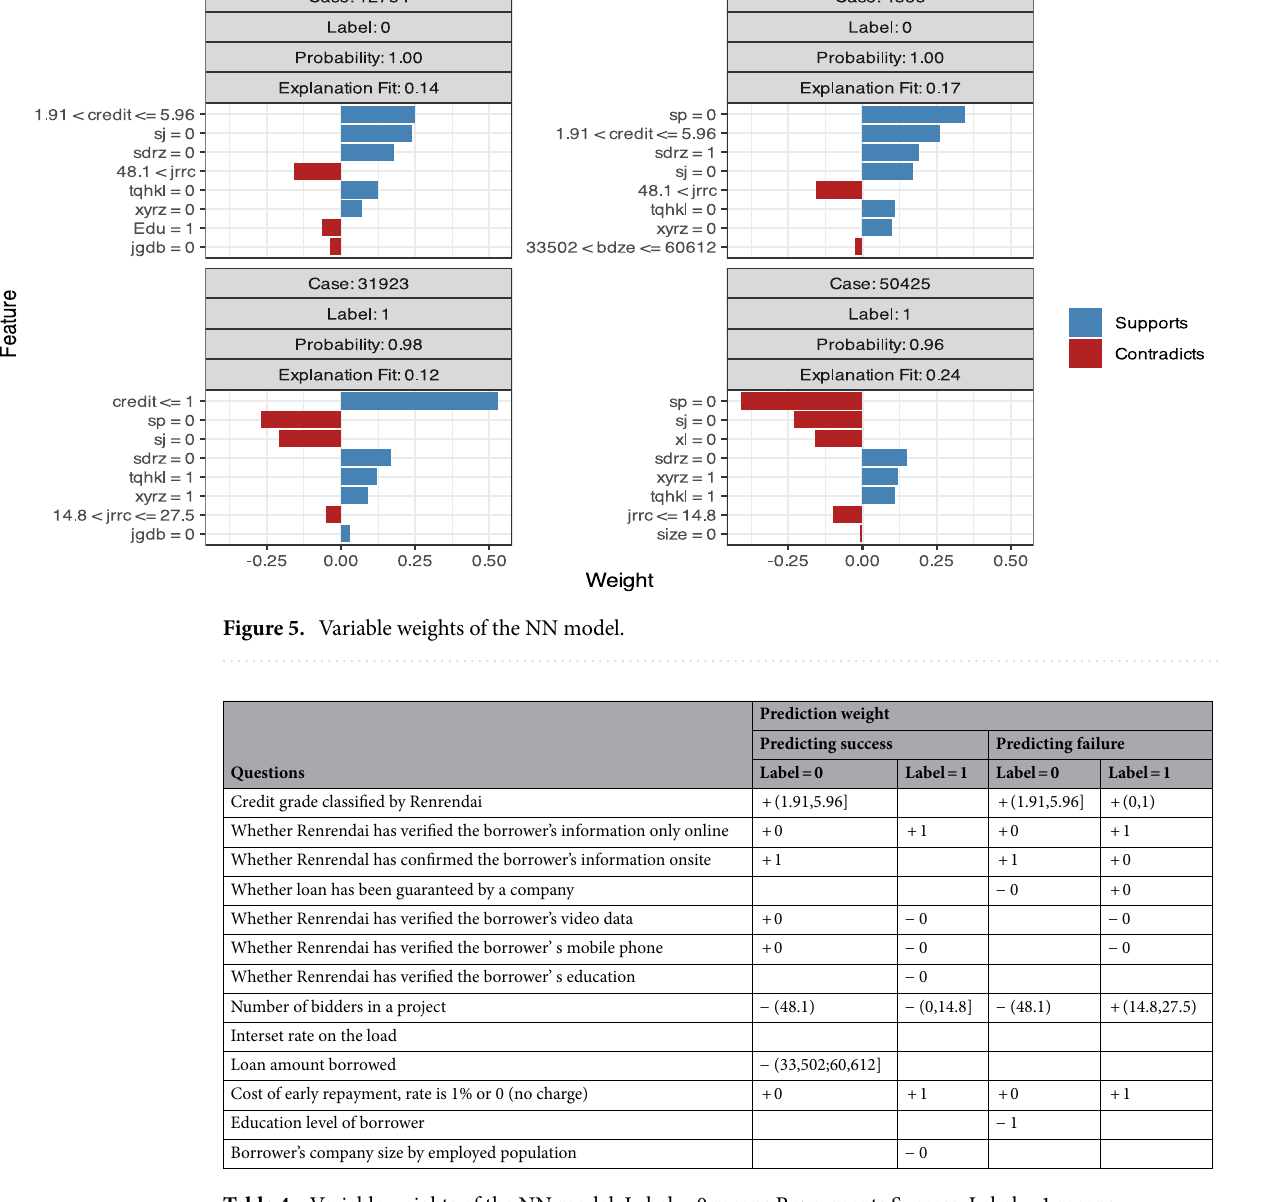
Table 4. Variable weights of the NN model. Label = 0 means Repayments Success. Label = 1 means Repayments Failure. ‘+’ means Supports, ‘−’ means